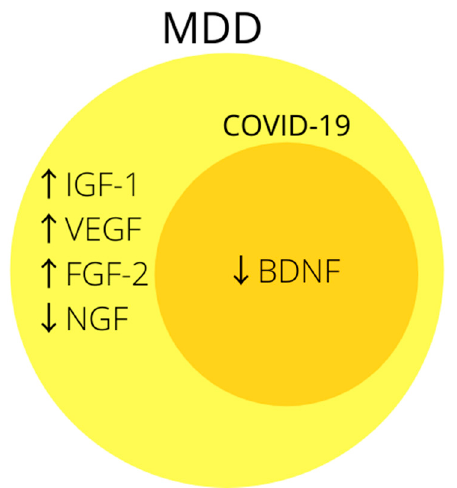
Figure 3. Summary of the most common changes in growth factors in MDD. Note that biomarkers inside dark-yellow circle coincide with changes in growth factors in COVID-19. Abbreviations: ↑ —increased concentration; ↓ —decreased concentration; BDNF—brain derived neurotrophic factor; FGF-2—fibroblast growth factor-2; IGF-1—insulin-like growth factor-1; NGF—nerve growth factor; VEGF—vascular endothelial growth factor.